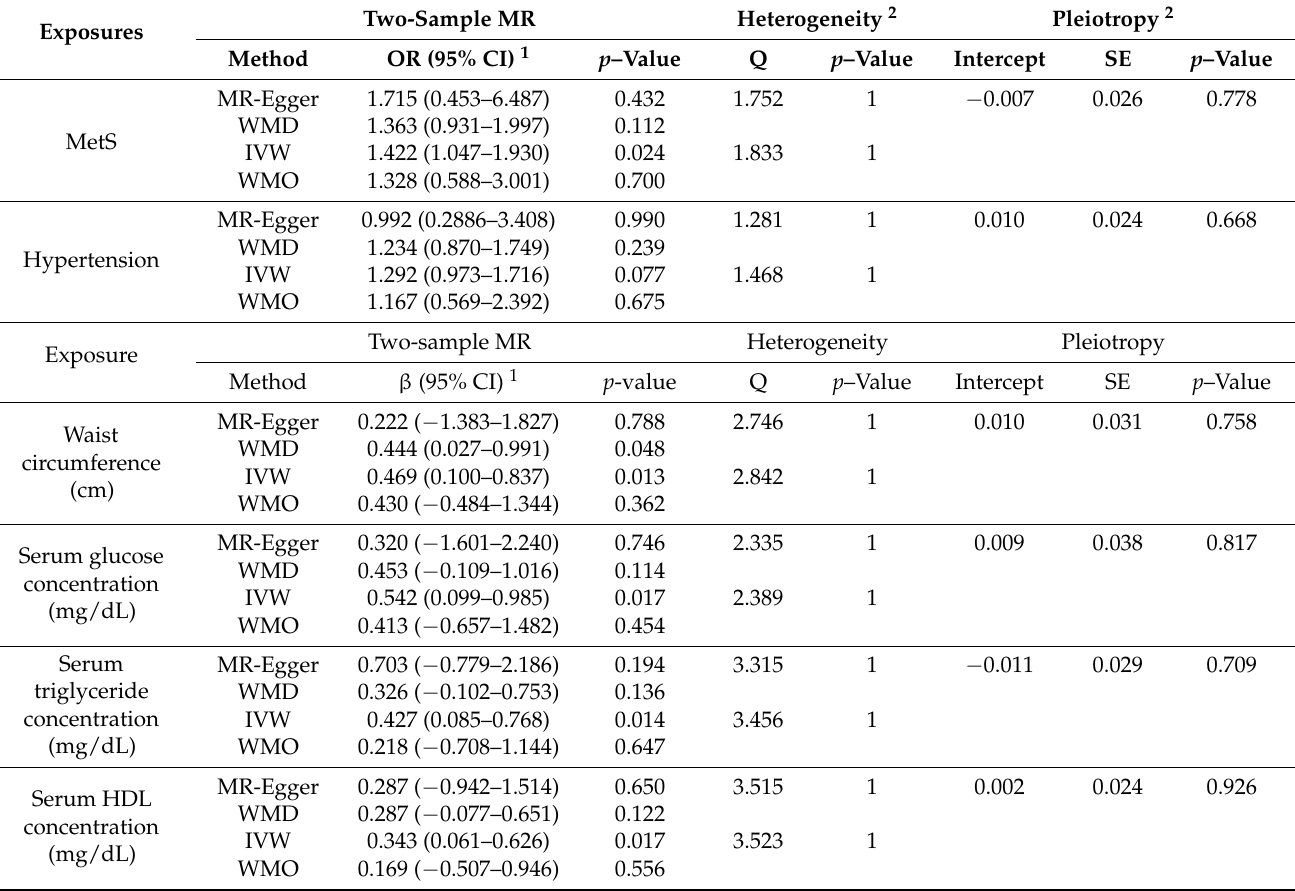
Table 4. Association of plant-based diet (PBD) intake with metabolic syndrome (MetS), including its traits, using two-sample Mendelian randomization